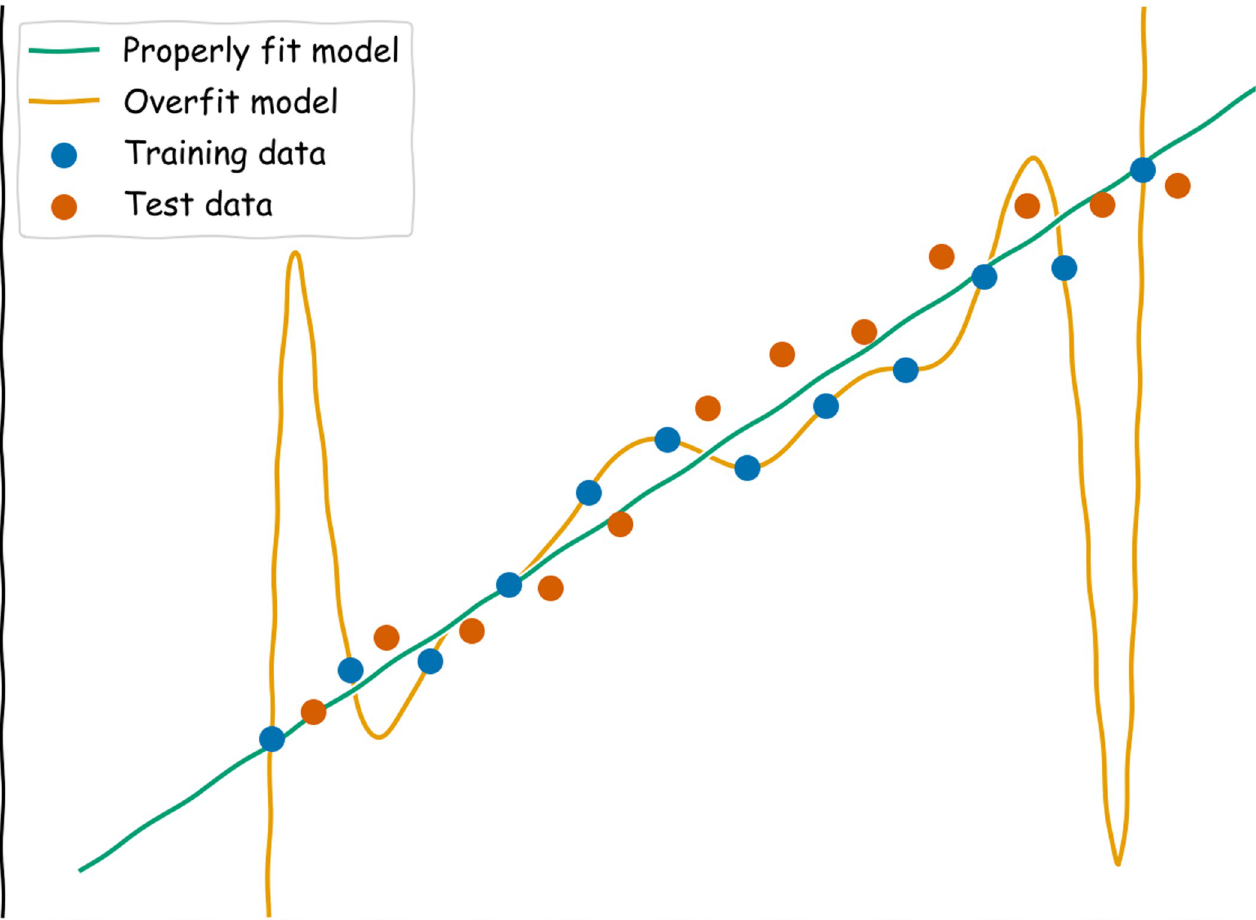
Fig 2. A visual example of overfitting and failure to generalize. While a high-degree polynomial achieves high accuracy on its training data, it performs poorly on the test data that have not been seen before. That is, the model has memorized the training dataset specifically rather than learning a generalizable pattern that represents data of this type. In contrast, a simple linear regression works equally well on both